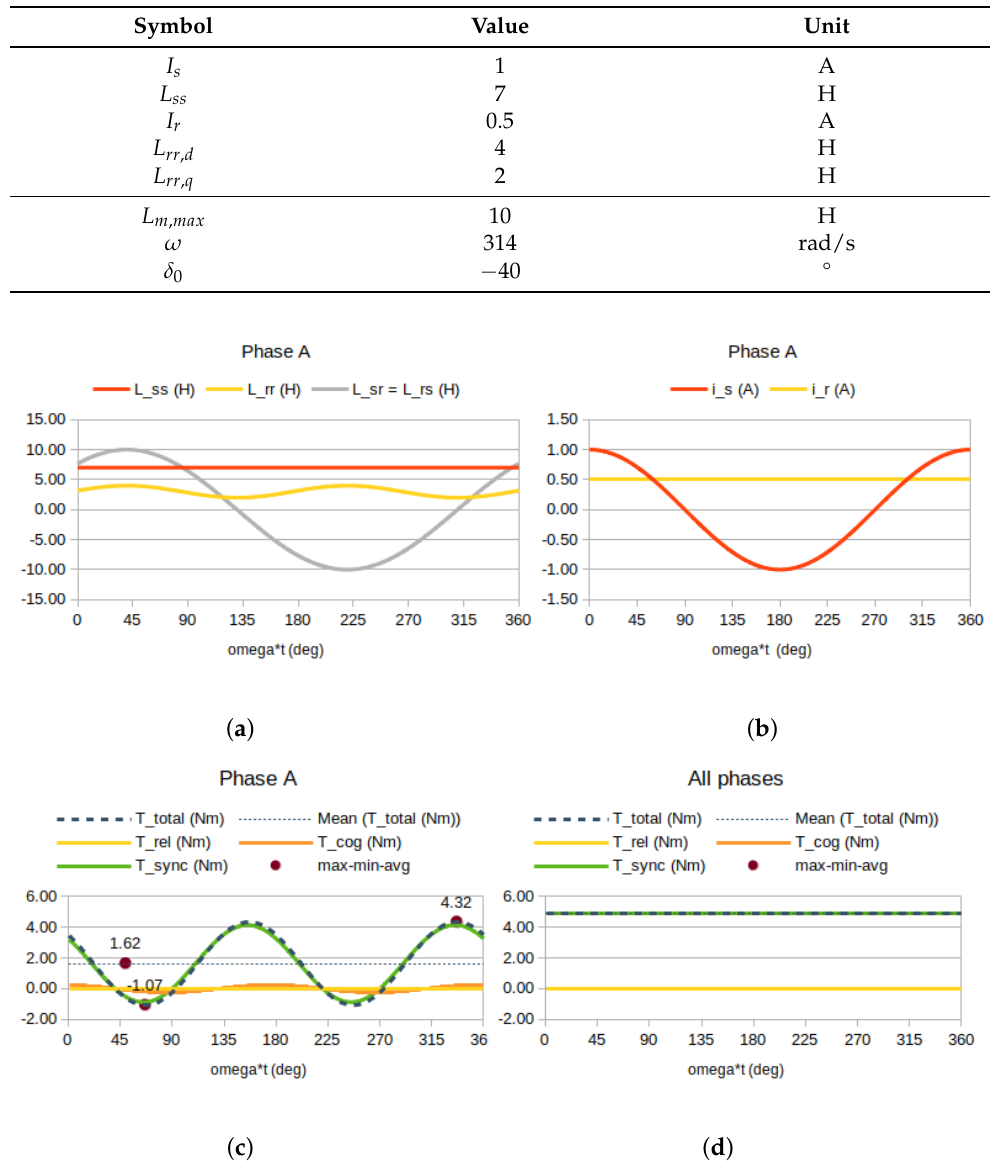
Figure 12. ( a ) Inductances, ( b ) currents, ( c ) single-phase torques, and ( d ) three-phase torques of a TFM, assuming a sinusoidal